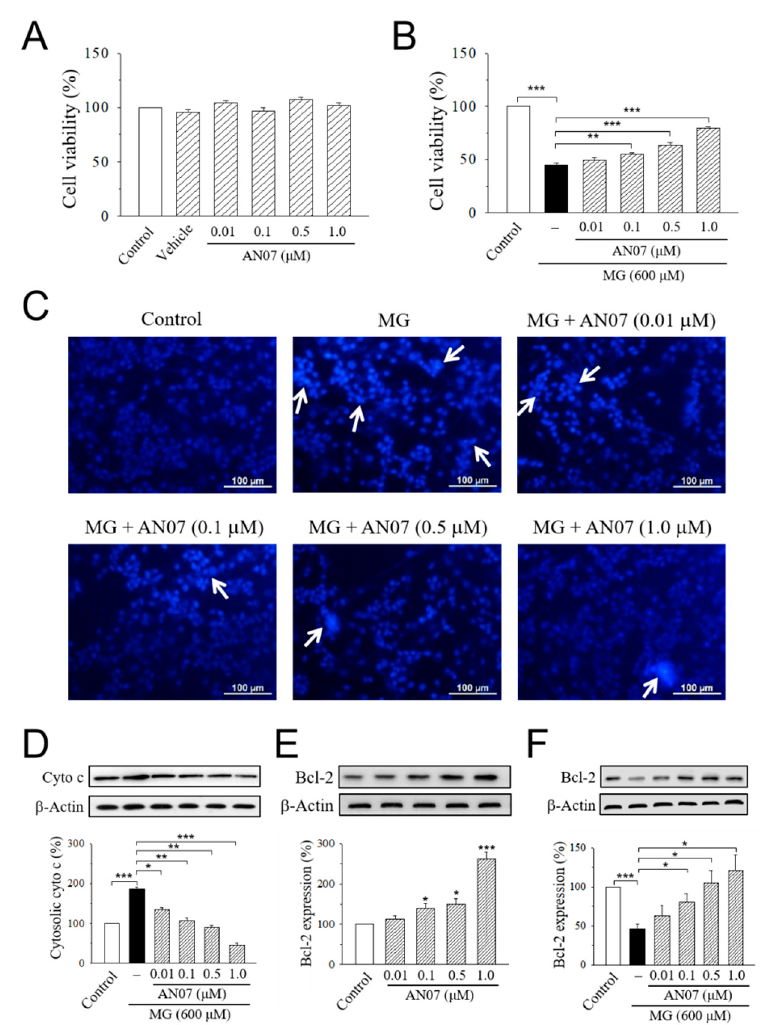
Figure 5. AN07 protects against methylglyoxal (MG)-induced apoptotic death in SH-SY5Y cells. ( A , B ) E ff ects of AN07 on cell viability of normal ( A ) or MG-treated ( B ) SH-SY5Y cells. SH-SY5Y cells were pre-treated with AN07 (0.01–1.0 µ M) for 1 h and then exposed to 600 µ M MG for another 24 h. Cell viability was determined by MTT assay. ( C ) Representative fluorescent images showing the protective e ff ects of AN07 on apoptotic nuclear condensation. Nuclear condensation (white arrow) was determined by Hoechst 33342 staining and observed by a fluorescent microscope. Scale bar, 100 µ m. ( D ) E ff ects of AN07 on cytosolic cytochrome c (cyto c) expression in MG-treated cells. ( E , F ) E ff ects of AN07 on B-cell lymphoma 2 (Bcl-2) expression in normal ( E ) or MG-treated ( F ) cells. Upper panels, representative immunoblots. Lower panels, densitometry analyses of the relative ratio of protein / β -actin protein, represented as percentages of the control group. Columns, mean ± S.E.M. from at least three independent experiments. * p < 0.05, ** p < 0.01, *** p < 0.001, compared with control or indicated groups.